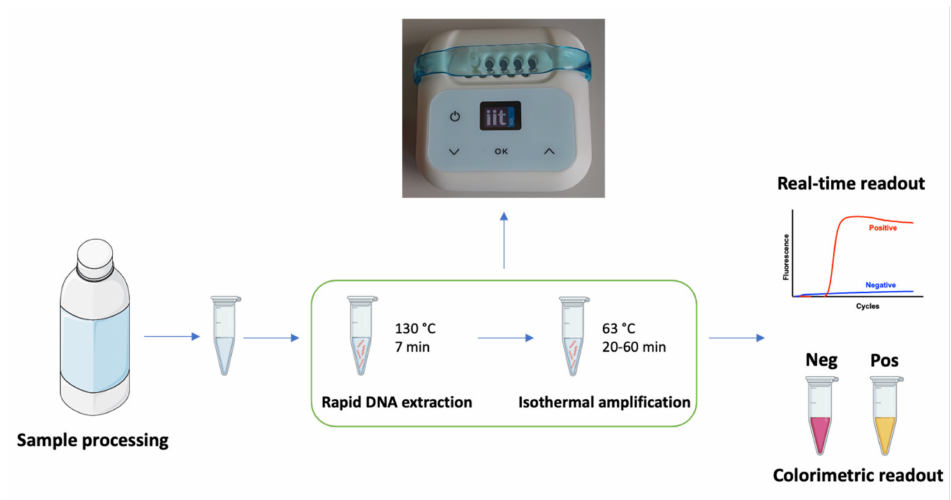
Figure 1. Schematic workflow of the POC process for C. tyrobutyricum identification. The method comprises three steps: milk sample processing, rapid DNA extraction performed at 130 ◦ C for 7 min, and DNA isothermal amplification performed at 63 ◦ C for 20–60 min, with a fluorescent or naked-eye colorimetric